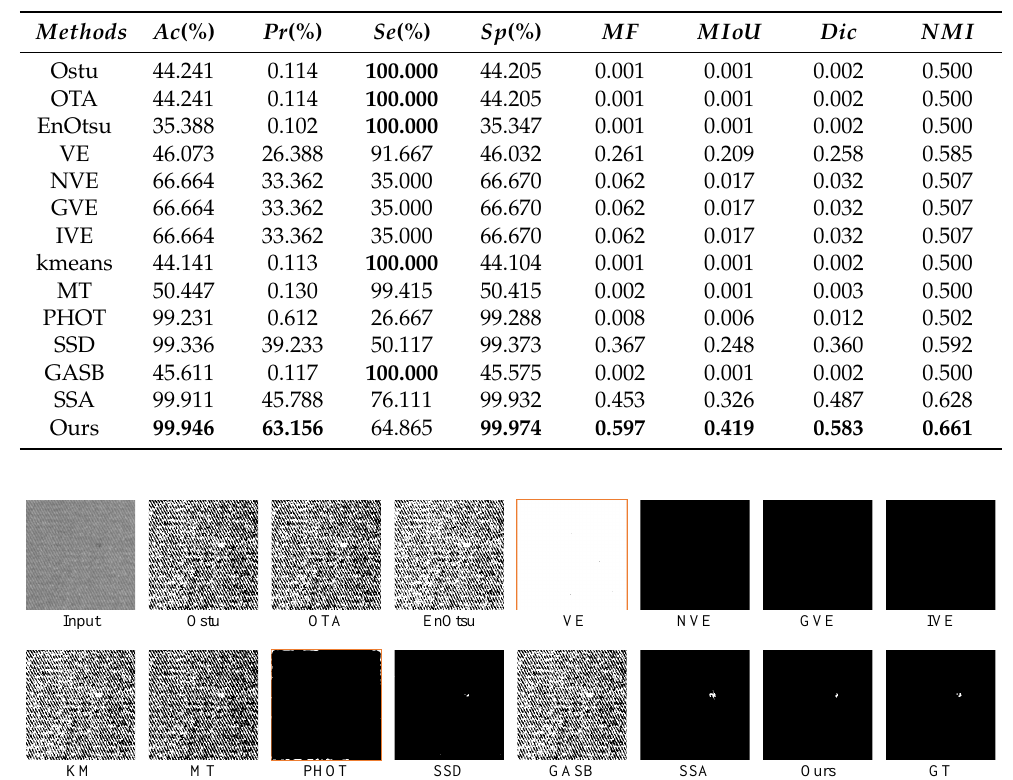
Table 2. Results on fabric images in terms of Ac (%), Pr (%), Sp (%), Se (%), MF , MIoU , Dic , and NMI .